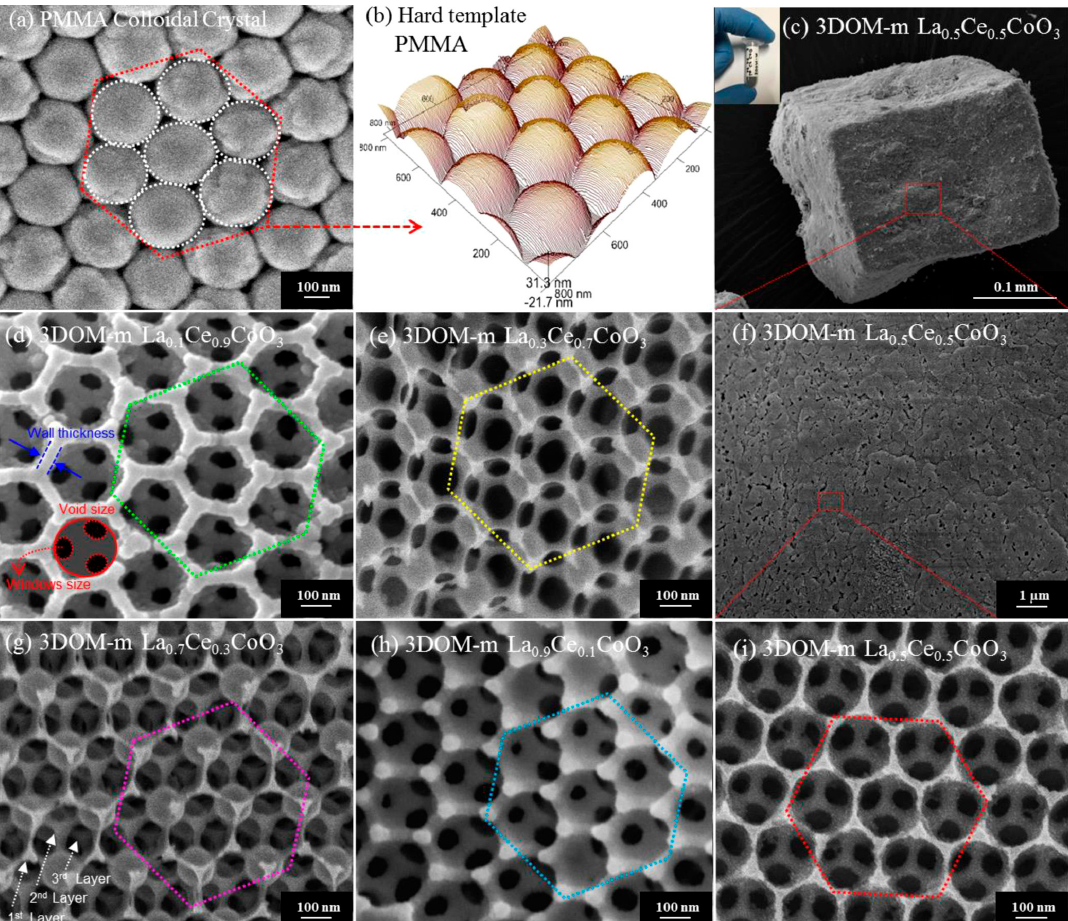
Figure 6. FE-HRSEM and 3D-eAFM images of ( a , b ) the PMMA and 3DOM-m La 1– x Ce x CoO 3 catalysts where x = ( c , f , i ) 0.5, ( d ) 0.9, ( e ) 0.7, ( g ) 0.3, and ( h ) 0.1. Reprinted with permission from Ref. [60].